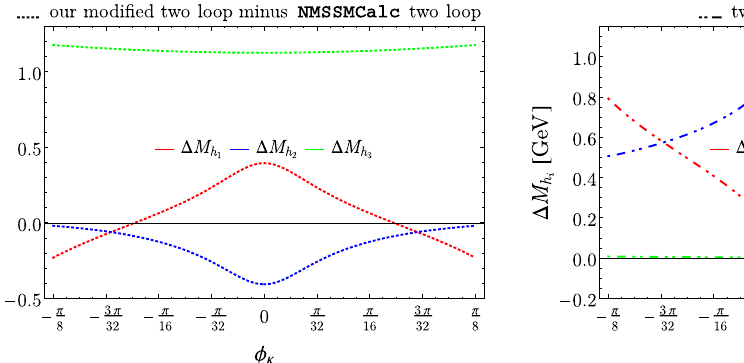
Fig. 5 Impact of two-loop contributions in the scenario of Fig. 4. On the left-hand side, (cid:13) M h ferences (for each of the three lightest Higgs states) between the pre- dictions of our “modified” scheme and NMSSMCALC : O (α t α s ) should